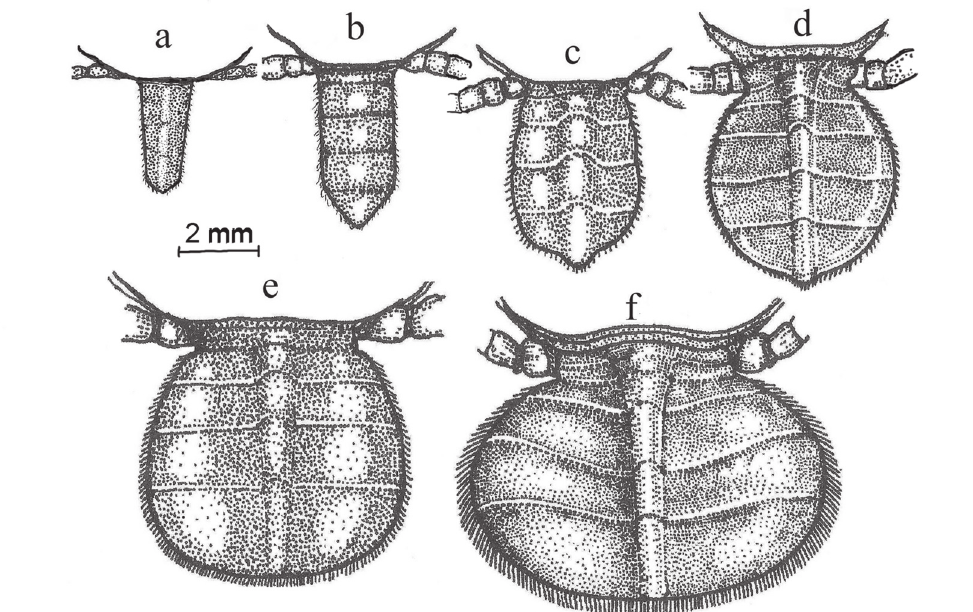
Fig . 1. – abdominal morphology of the different stages described. a: first immature stage (iMM 1); b: iMM 2; c: iMM 3; d, iMM 4; e: ado- lescent (ado); f: adult or mature